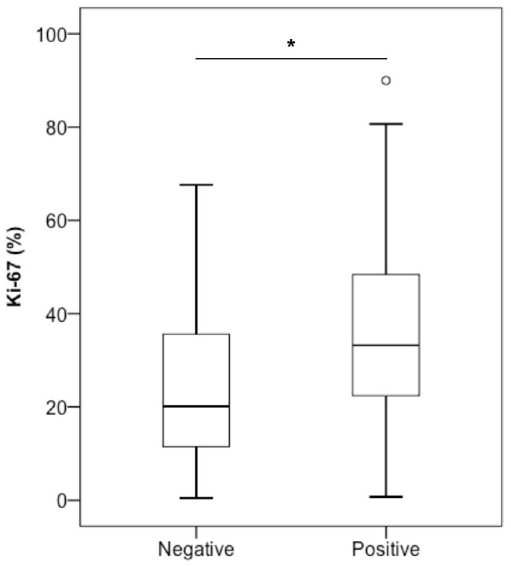
Figure 2. Ki-67 index distribution in TFAM + and TFAM- EOC tumours. EOC tumours with negative expression of TFAM ( n =18) showed significantly lower Ki-67 index compared to tumours with positive expression of TFAM ( n =35) (Mann-Whitney U, p